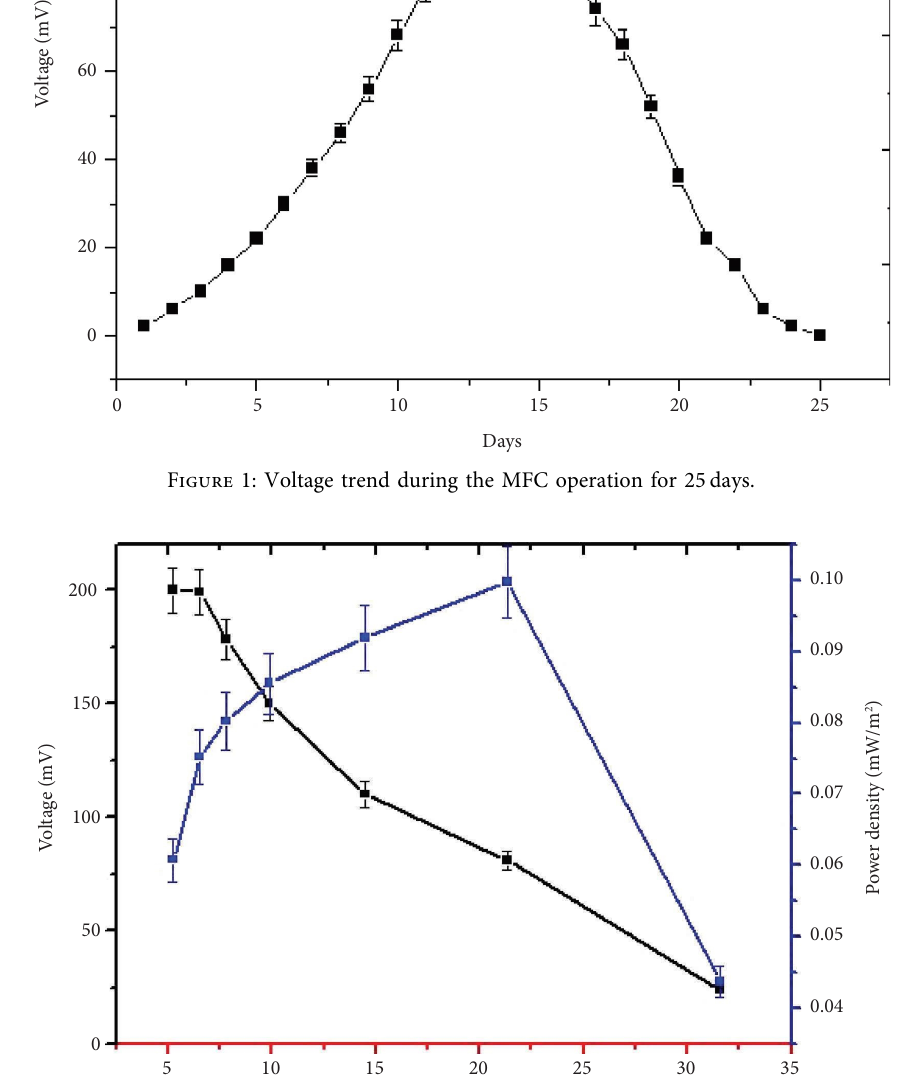
Figure 2: Polarization behaviour of operation.